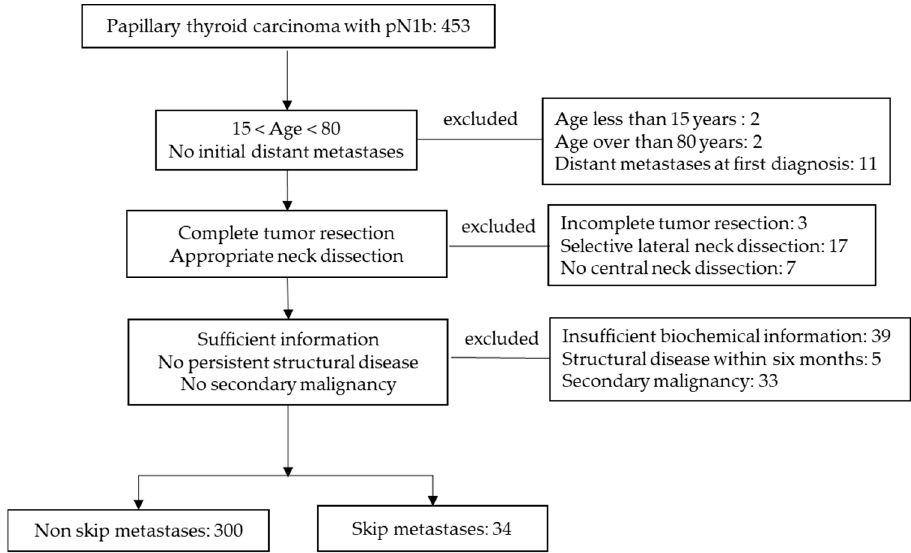
Figure 1. Flowchart of study population.